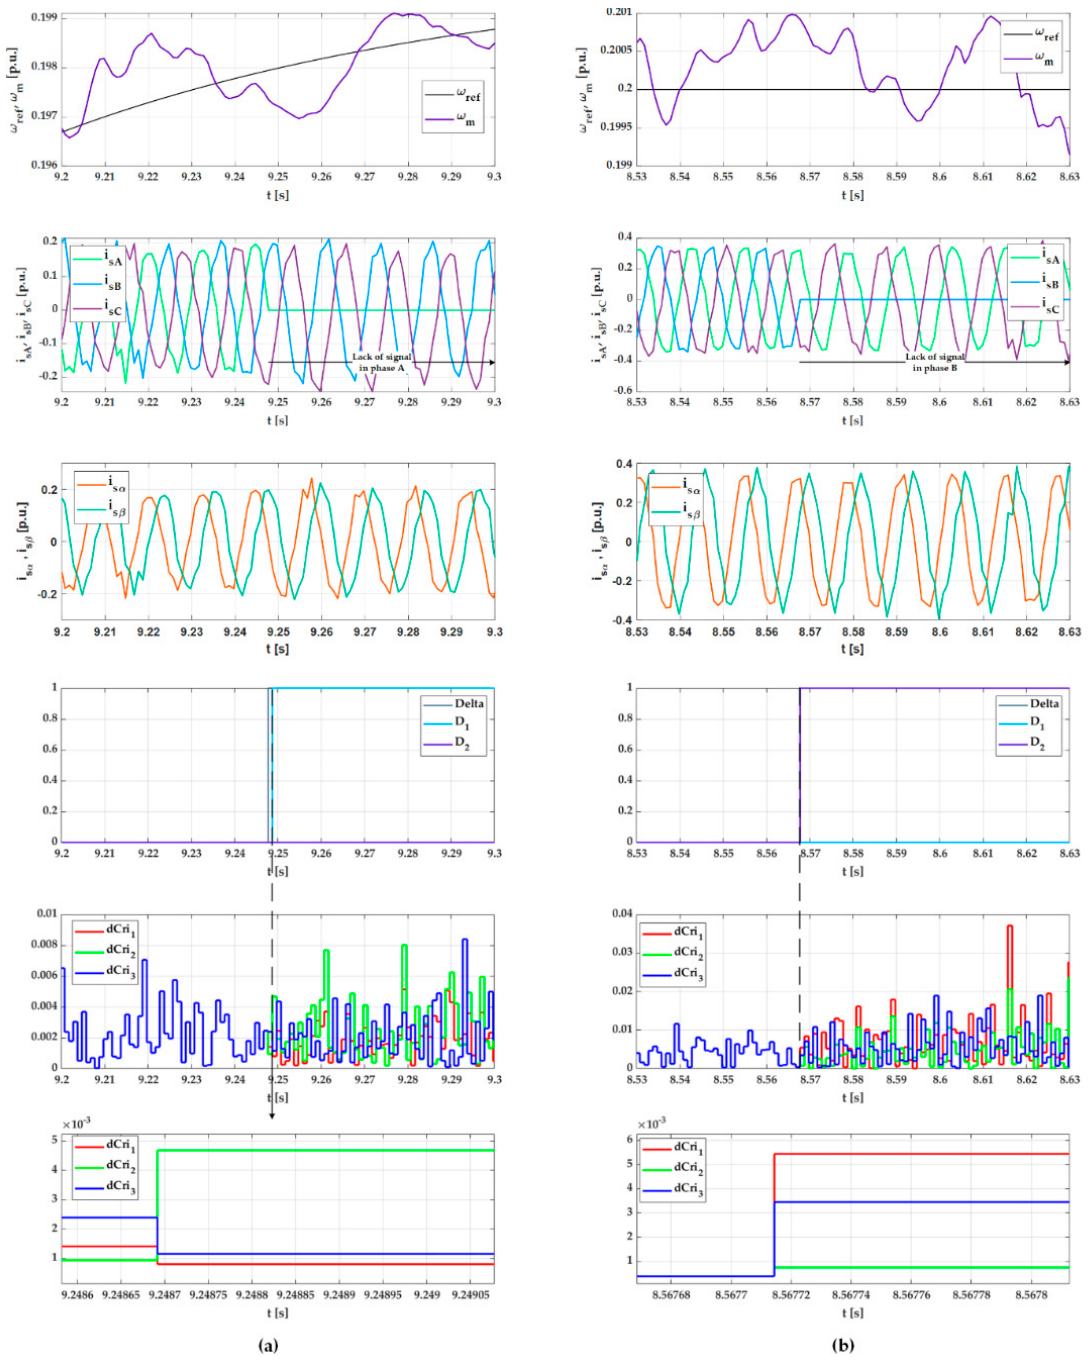
Figure 13. Transients of stator currents, stator current components— i α , i β , detector response, and marker error transients during lack of signal in phase A ( a ) and B ( b ) in control structure with compensation mechanism.